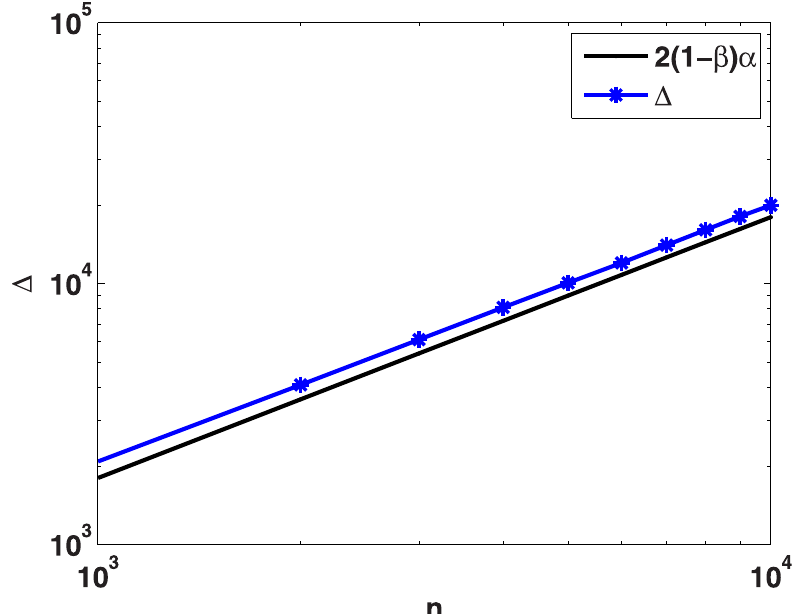
Fig 5. Number of triangles ( Δ ) is plotted for different size of networks generated by the proposed model by setting β = 0.1, b = 1, and α = 1.0. Theoretically calculated lower bound (2(1 − β ) α ) is also plotted. Horizontal-axis represents the number of nodes in the networks and the vertical-axis represents number of triangles in the